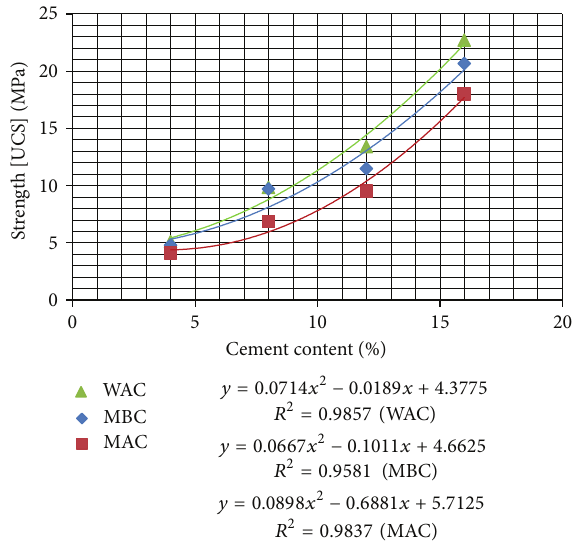
Figure 11: UCS for different cement contents (dry durability condition).